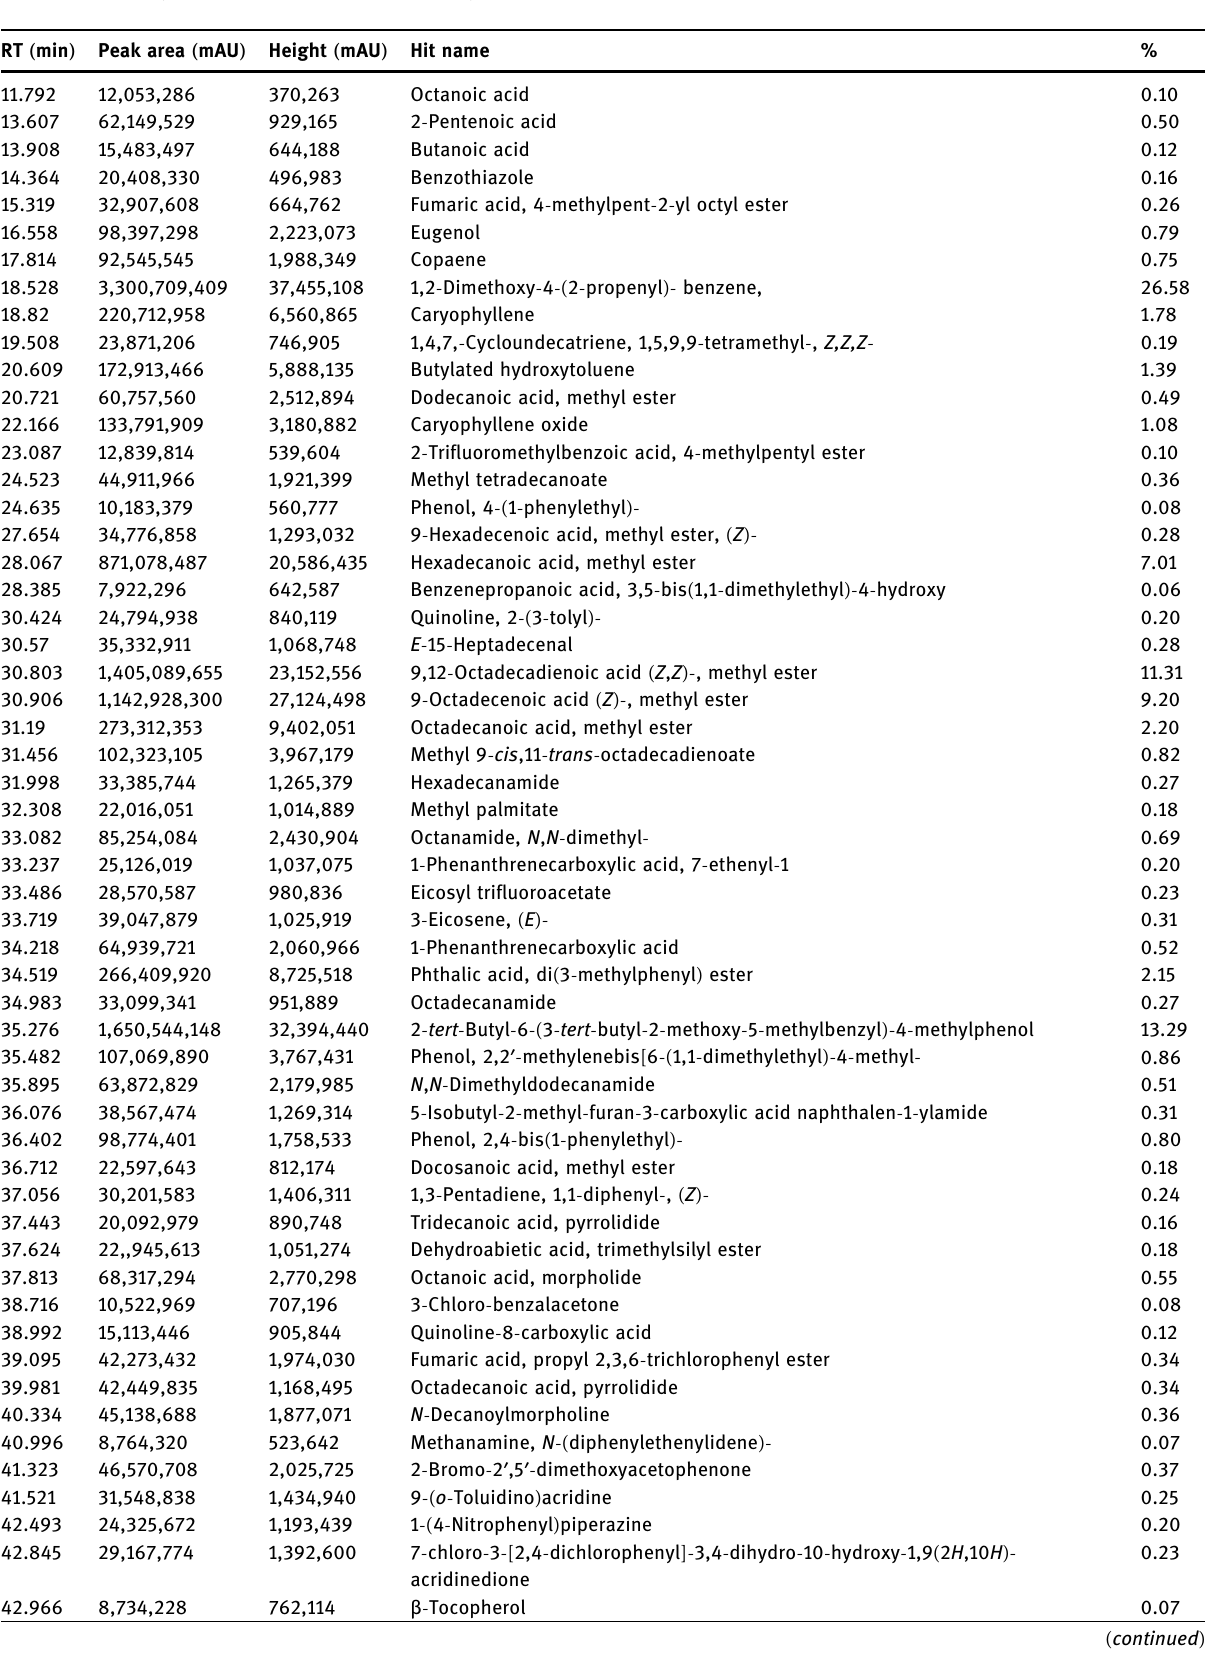
Table 1: Chemical pro fi le of glove bud oil identi fi ed by